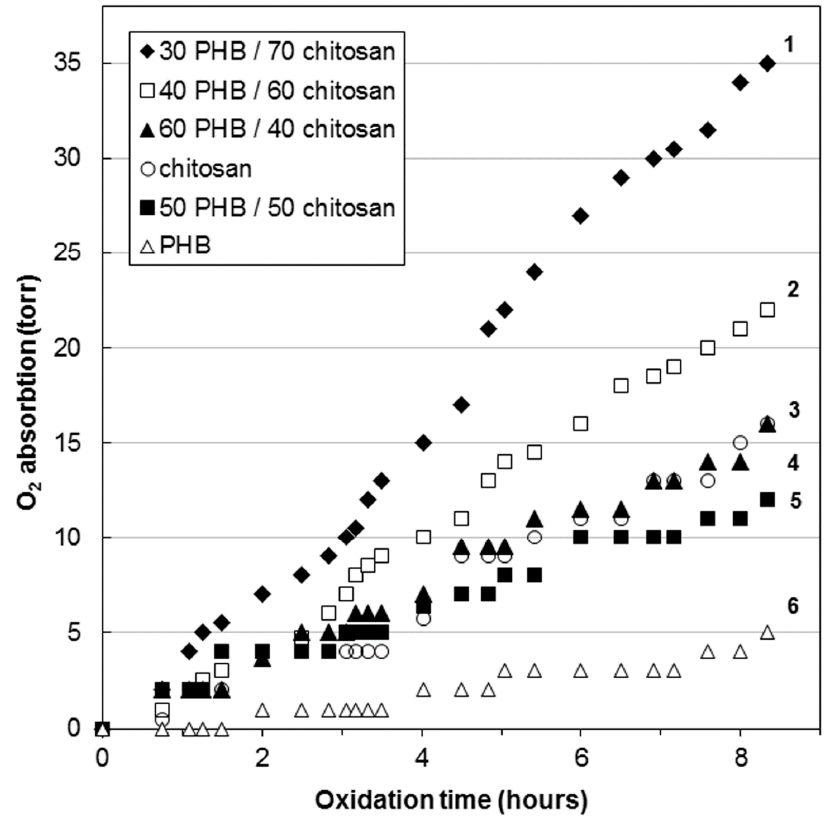
Figure 6. Kinetic curves of oxygen absorption by nonwoven fibrous materials PHB/CHT: (30/70)—1, (40/60)—2, (60/40)—3, (0/100)—4, (50/50)—5, and (100/0)—6. 308